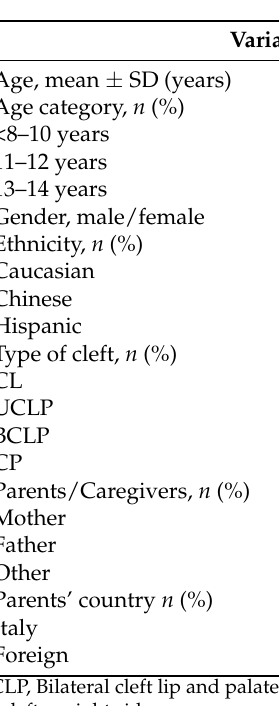
Table 1. General characteristics of the